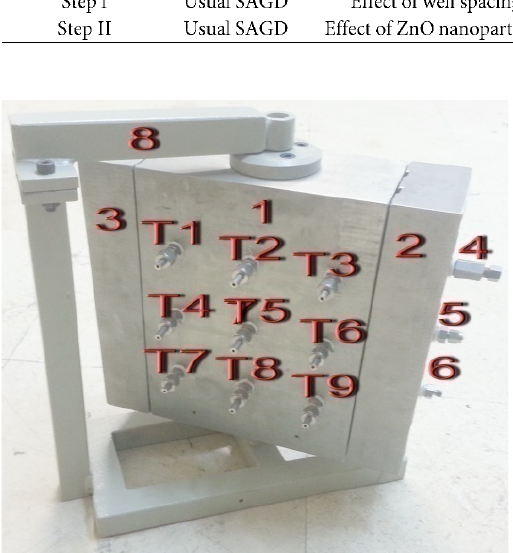
Fig. 1. The schematic of physical model; 1- The main body with inside dimensions 20×20×4 cm; 2- Upper cap with dimensions of 31.5×25.8×11 cm; 3- Lower cap with dimensions of 31.5×25.8×11 cm; 4- Steam injector well in 15 cm from producer; 5- Steam injector well in 10 cm from producerp; 6- Oil producer well in the bottom of model; 7- A total of 9 thermocouple (T1-T9) probes installed to the model. The thermocouples connected to the data acquisition instrument, which recorded and displayed the temperature profile within the model during the experiment; 8- The basis for rotating the model in different angels.